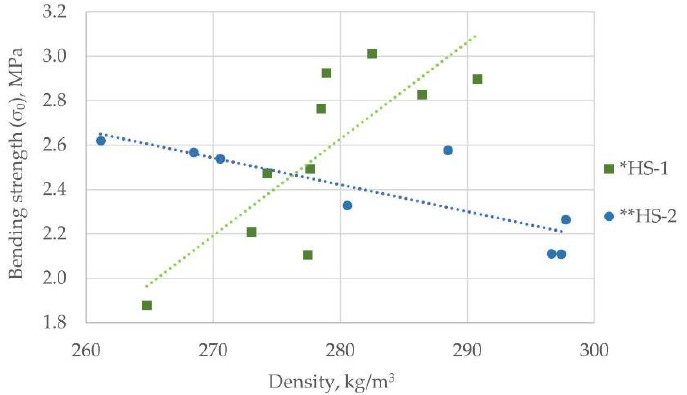
Figure 8. Bending strength comparison for hemp shives boards from both particle size